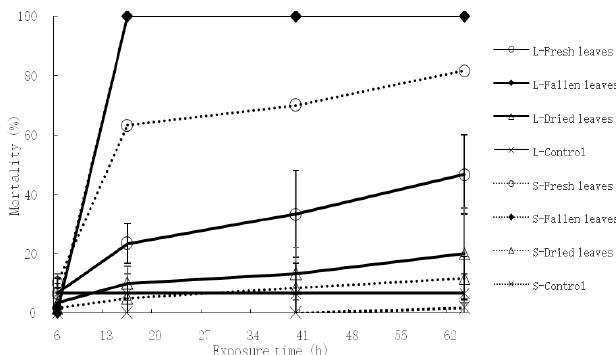
Fig 1 . Mortalities of workers (L: large workers, S: Small workers) after treated with different mashed leaves of M. alba ( Duncan′S Multiple-Range test, SPSS17.0).